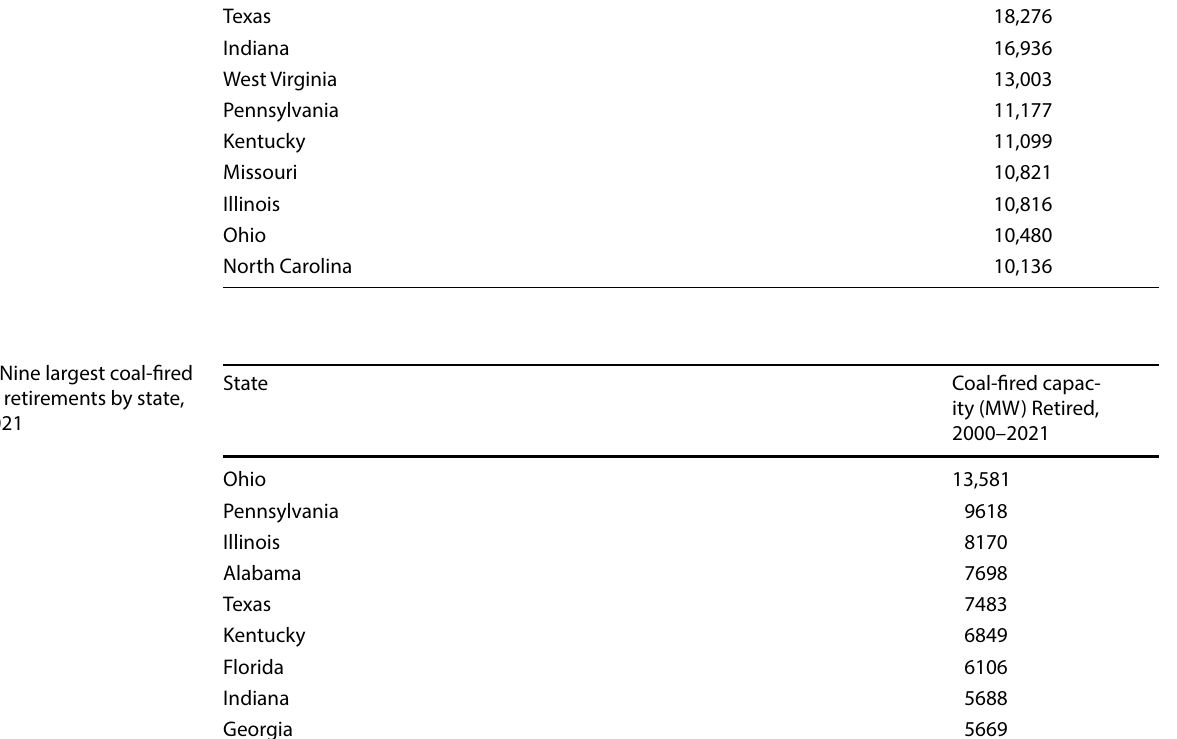
Table 1 Nine largest coal-fired operating capacity by state,